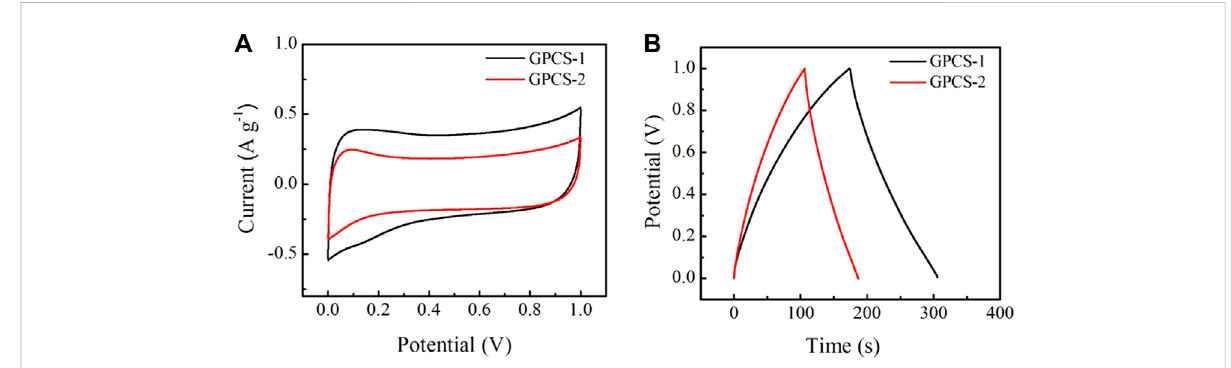
FIGURE 5 Capacitive performances ofGPCSs-1 andGPCSs-2symmetrical supercapacitors in1 MH 2 SO 4 aqueous electrolyte. (A) CVcurvesatascanrate of 5 mV s − 1 . (B) GCD curves at a current density of 1 A g − 1 .